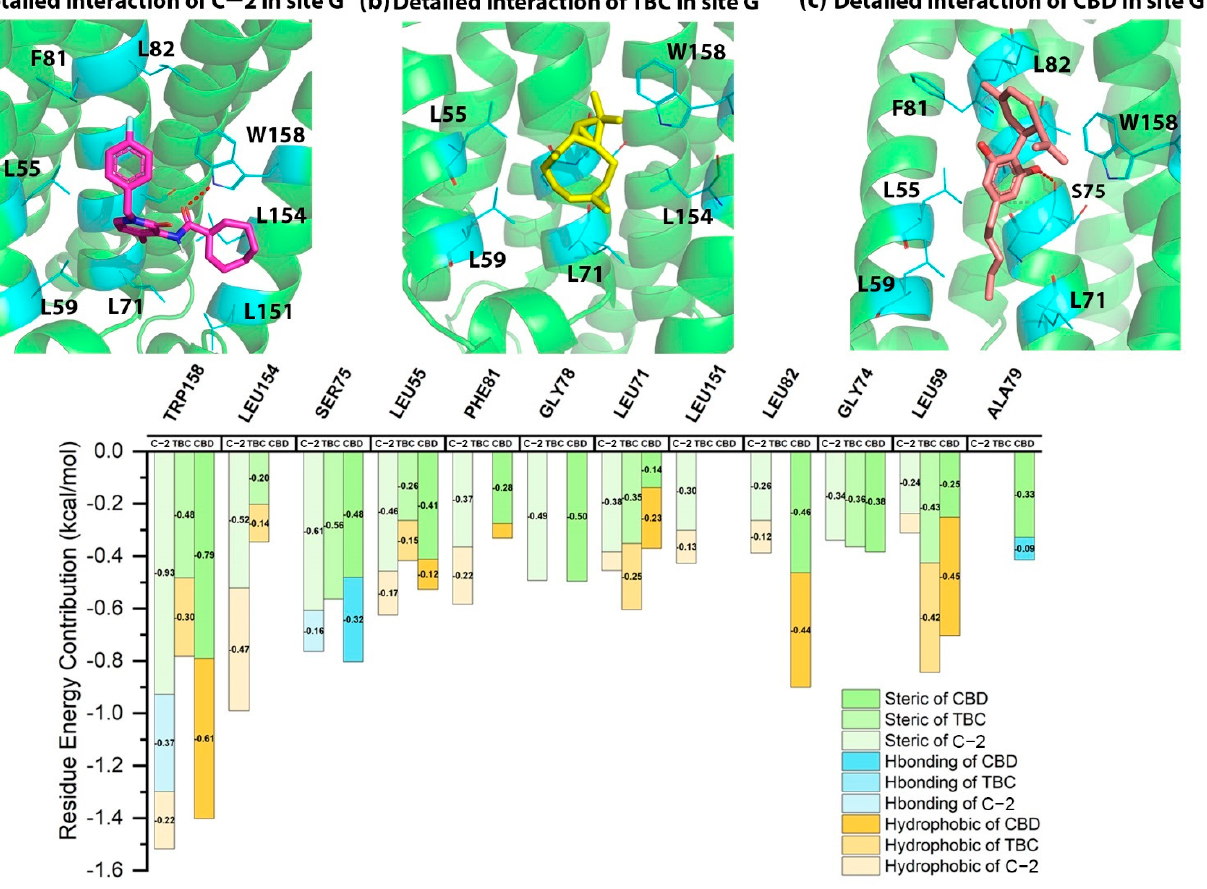
Figure 3. The detailed interactions and residue energy contribution of C-2, TBC and CBD in site G. ( a ) The detailed binding pose of C-2 in site G. ( b ) The detailed binding pose of TBC in site G. ( c ) The detailed binding pose of CBD in site G. ( d ) The comparisons of residue energy contribution of the key residues for these AMs in site G.